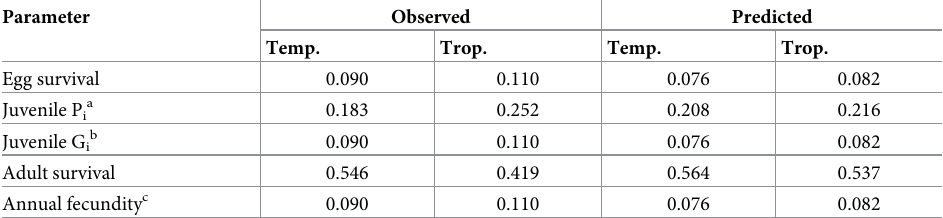
Table 4. Elasticity values. Elasticity values calculated from stage structured matrix population models for demo- graphic parameters in temperate (Temp.) and tropical (Trop.) freshwater turtles. Observed elasticities were derived from median values from the scientific literature (S1 Table) and predicted values are from the 95% confidence set of GAM models (Table 3). Parameter Observed Predicted Temp. Trop. Temp. Trop. Egg